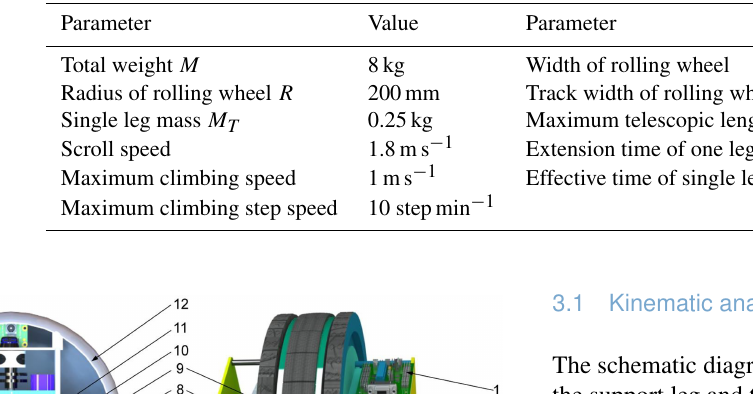
Figure 1. The leg telescopic structure. Table 1. Wheel and leg deformation mechanism parameters.